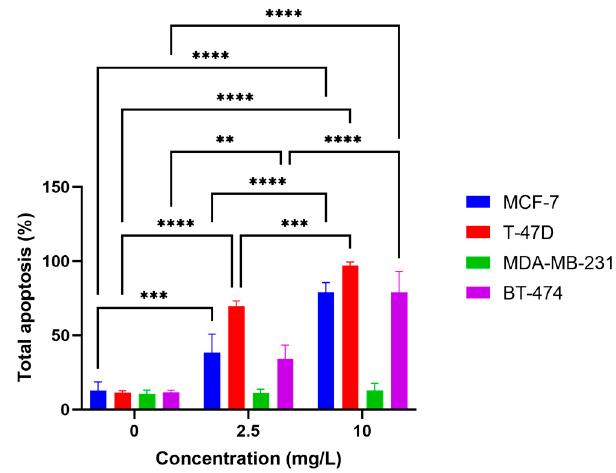
Figure 4. Apoptosis in the four breast cancer cell lines treated with o-GQD for 72 h determined using the Annexin V assay. The data indicate averages from triplicates, and the error bars indicate SD. Significance is determined by using two-way ANOVA statistical analysis. The significant differences are indicated by using *. **: p < 0.01, ***: p < 0.001, ****: p < 0.0001.